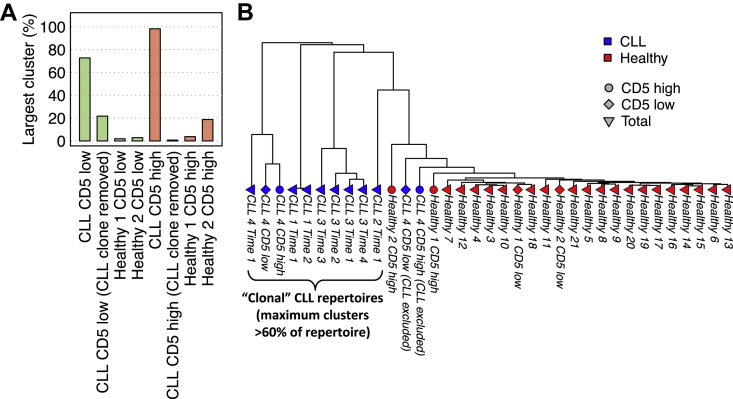
Analysis A.of the nonleukemic counterpart of CD5+/– B-cell populations in CLL patients. (A) Comparisons of the largest cluster sizes (as a percentage of total reads) and (B) hierarchical clustering of IgHV-J gene usage similarities between CD5high (red) and CD5low (green) B-cell populations for two healthy individuals and CLL patient 4 (either for all reads in the sample, or all reads that were unrelated to the CLL clone, defined as >30 bp differences and/or >10 gaps within an alignment from the CLL clonal sequence). The CD5high and CD5low samples from patient 4 have increased clonality compared to healthy individuals (Supplementary Fig. E5A). However when the sequences related to the CLL clone are removed from the CD5high and CD5low samples (i.e., the nonleukemic counterpart of the repertoire), there is no significant difference in clonality of V-J gene usage frequencies. Both CD5high and CD5low samples from CLL patient 4, when excluding the CLL clone, cluster together with the healthy individuals.